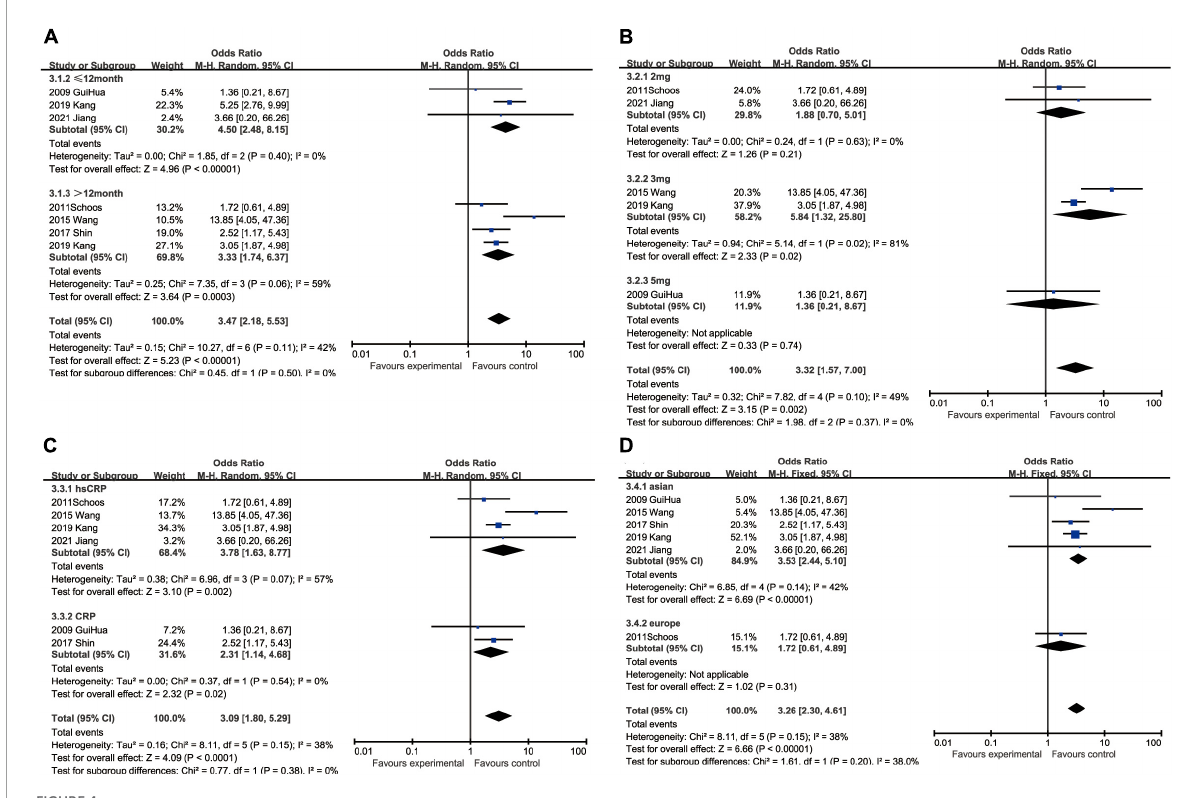
FIGURE4 Forrest plots of subgroup analysis assessing cardiovascular mortality associated with increased CRP: (A) subgroups based on follow-up; (B) subgroups based on cut-off value of hsCRP; (C) subgroups based on CRP and hsCRP; and (D) subgroups based on